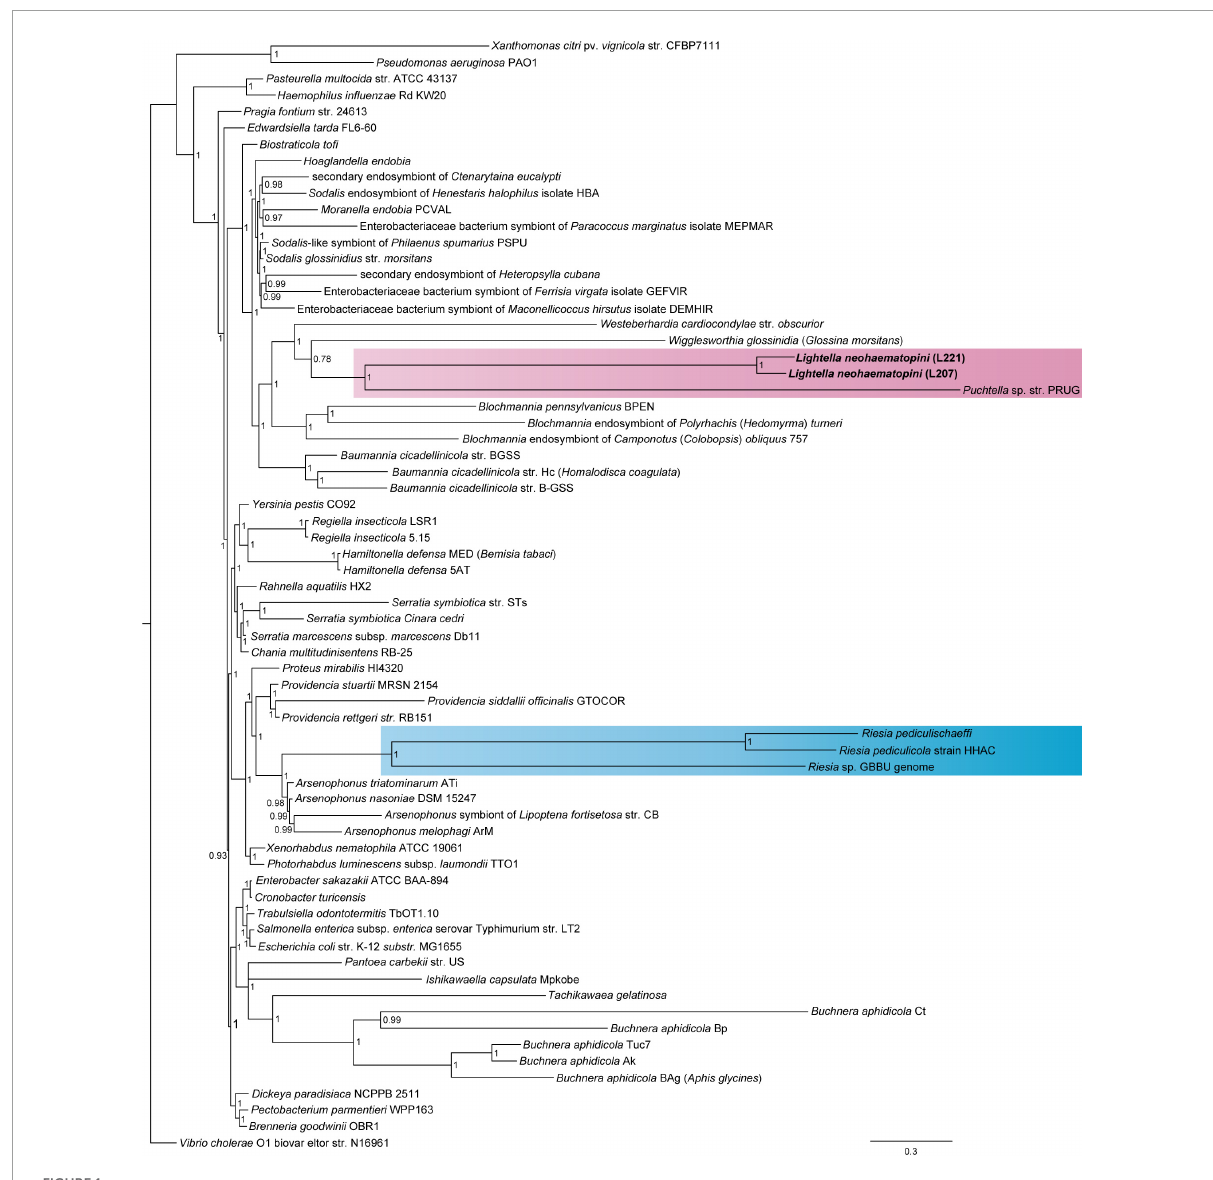
FIGURE1 Position of Lightella neohaematopini within Enterobacteriales revealed by PhyloBayes analysis (BI under CAT-GTR model) of the concatenated 14-protein “reduced phylogenetic matrix” (7,438 aa). Clustering of L. neohaemotopini together with the Puchtella sp. str. PRUG is indicated by pink background. Clustering of another louse symbiont, the genus Riesia , within Arsenophonus cluster is highlighted by blue background. Values at the nodes show posterior probabilities.